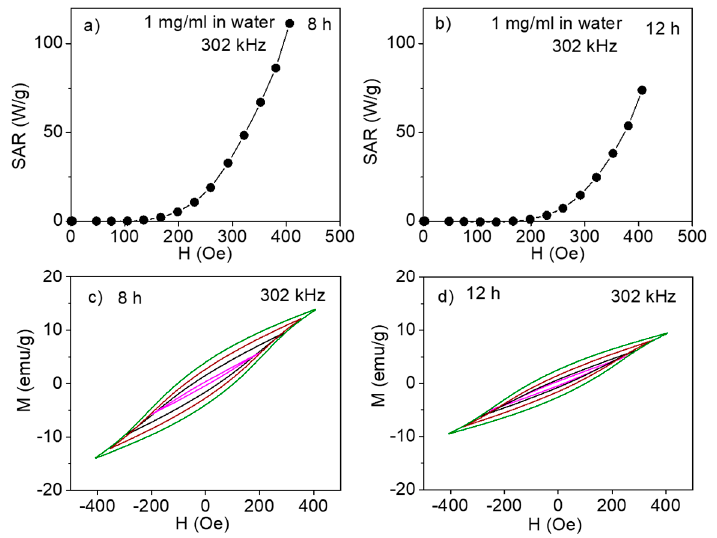
Figure 5. ( a , b ) SAR vs. AC magnetic field curves as obtained from ( c , d ) the corresponding dynamic hysteresis loops for multigrain Fe 3 O 4 nanorings after 8 h and 12 h of reaction, respectively.